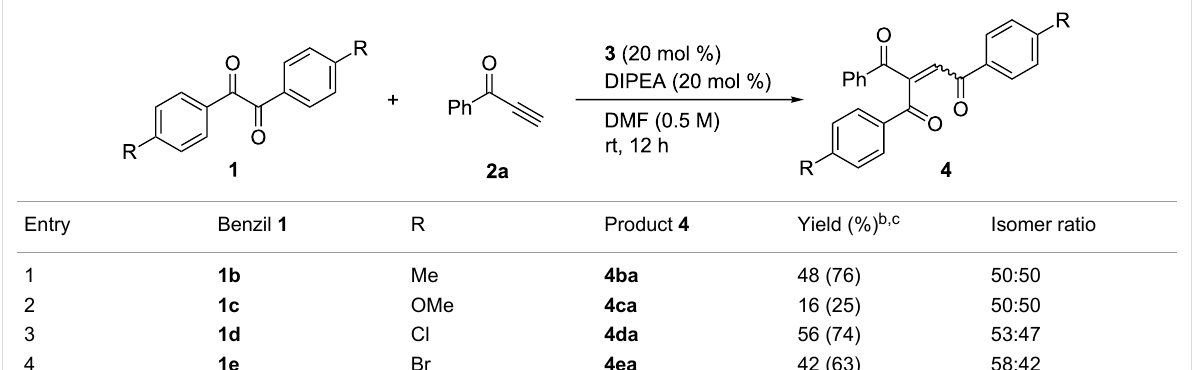
Table 2: Reaction of substituted benzils 1 with ynone 2a a .